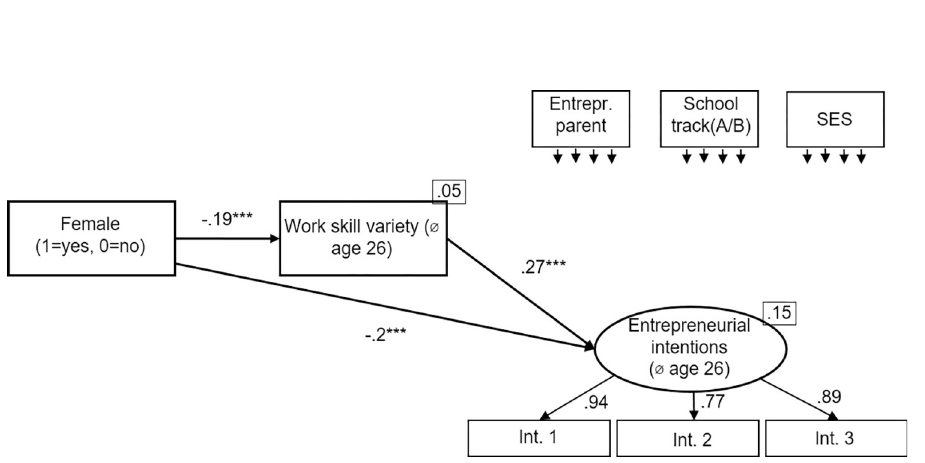
Fig 3. Educational skill variety as mediator. Standardized coefficients are given. R 2 is shown in the upper right corner of the dependent variables. Correlations between the control variables were allowed. � p < .05; �� p < .01; ��� p < .001.